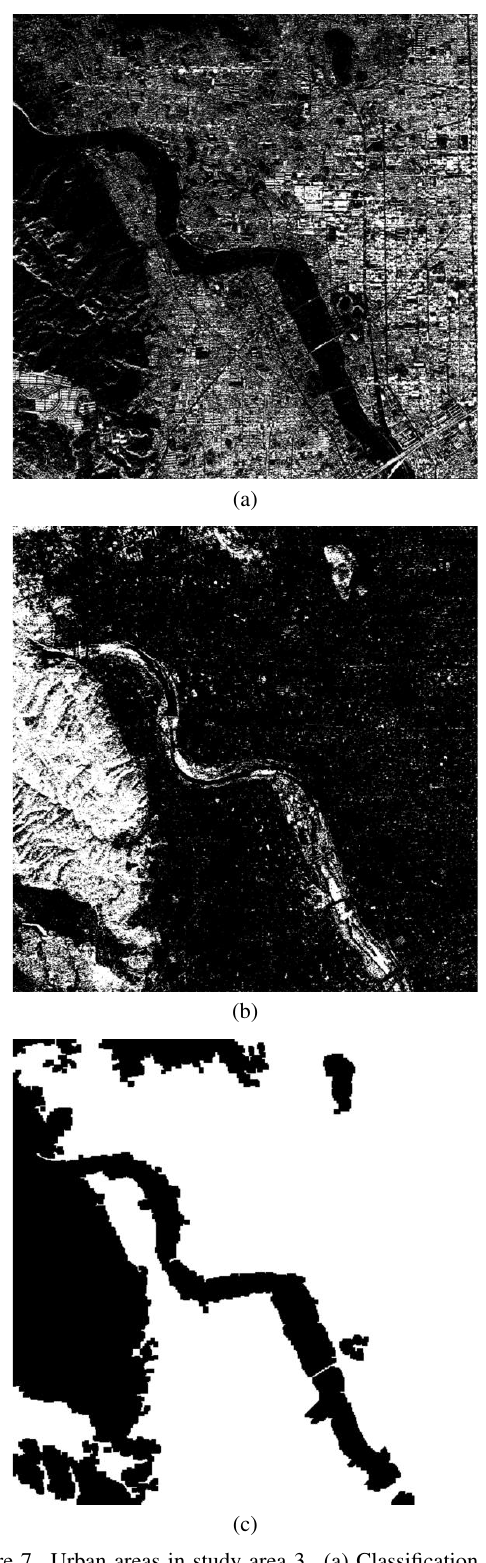
Figure 7. Urban areas in study area 3. (a) Classification result using TP and P v without closing, (b) classification result using (cid:13) HH;V V without closing, and (c) final result.